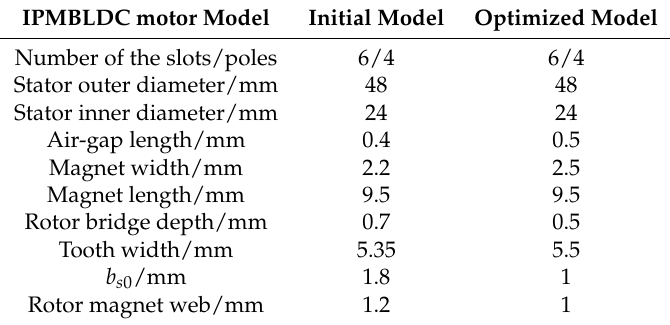
Table 4. The dimensions of the initial and optimized IPMBLDC motor